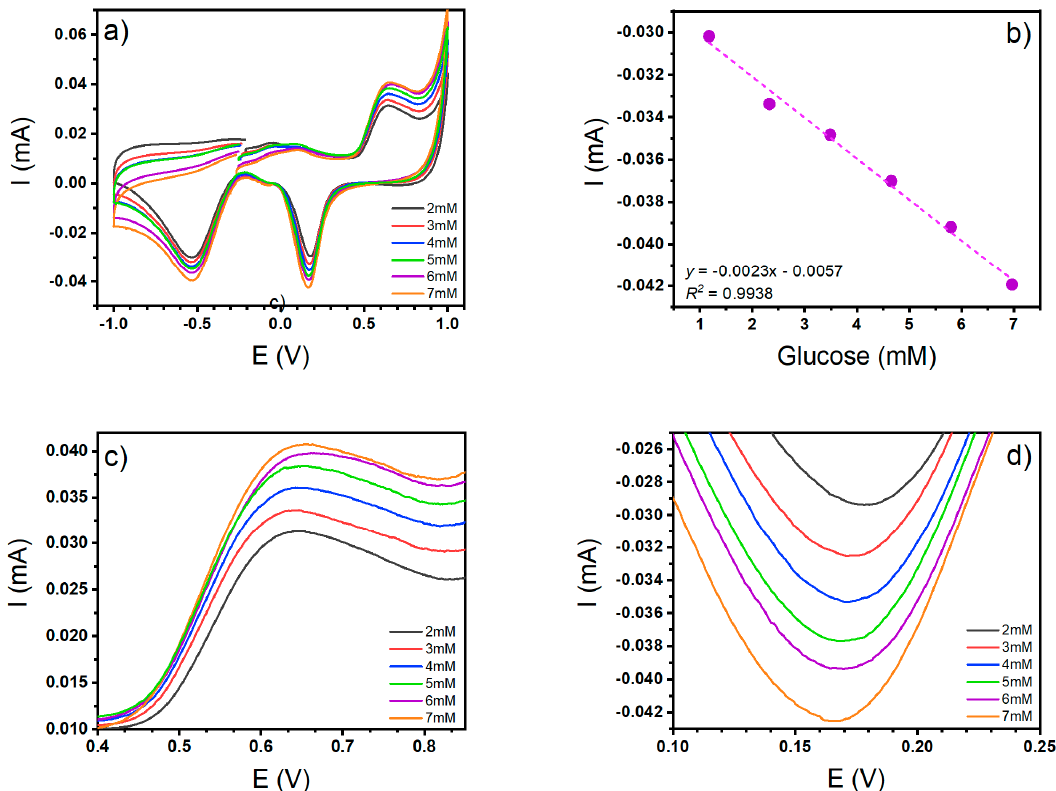
Figure 13. ( a ) Cyclic voltammetry to glucose at different concentrations, ( b ) Calibration curve using the cathodic peak currents, ( c ) Close-up of the oxidation signal, ( d ) Close-up of the reduction signal.